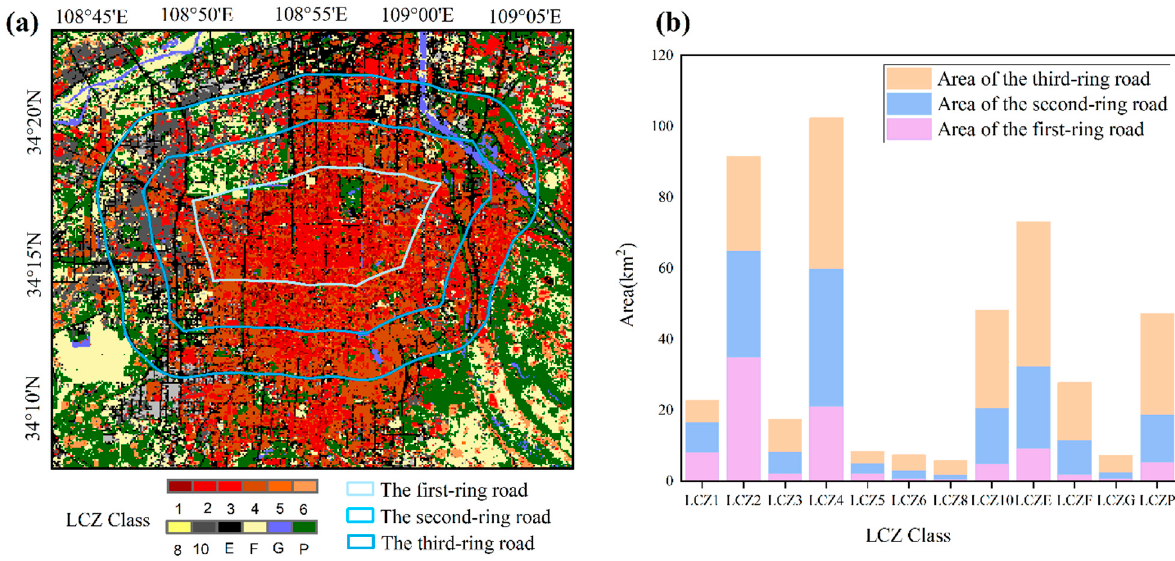
Figure 8. Distribution of LCZs within the three rings ( a ); histogram of the area of LCZs in the third ring ( b